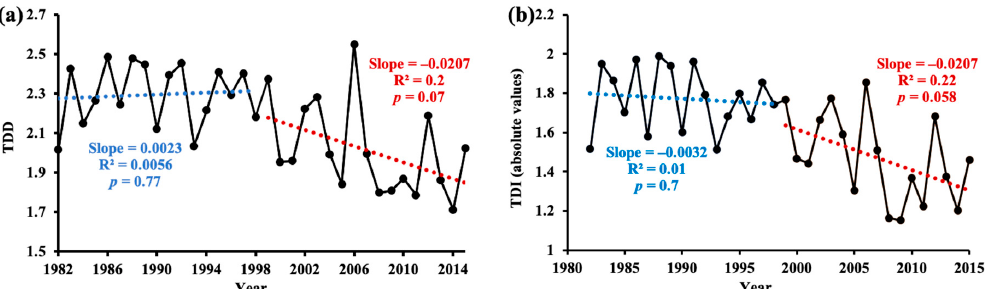
Figure 5. Inter-annual variations of ( a ) drought duration and ( b ) absolute value of drought intensity during 1982–1998 and 1999–2015. Each year value was averaged of all pixels. The blue line is the linear